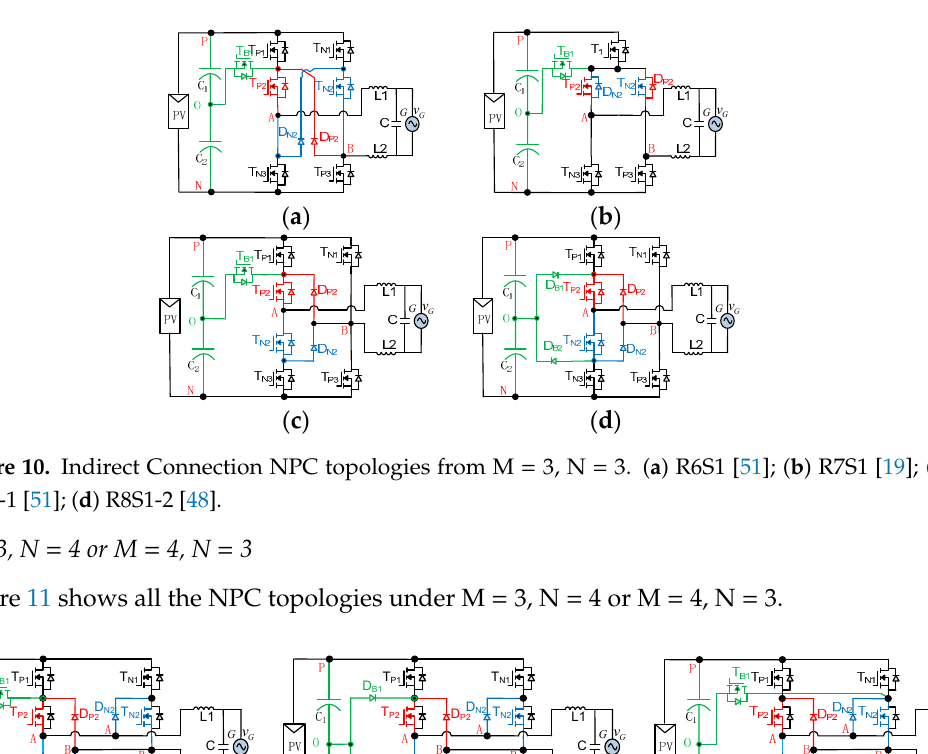
Figure 9. Indirect Connection NPC topologies from M = 2, N = 3 or M = 3, N = 2. ( a ) R4S1-1 [51]; ( b ) R4S1-2 [51]; ( c ) R4S1-3 [51]; ( d ) R5S1 [50].